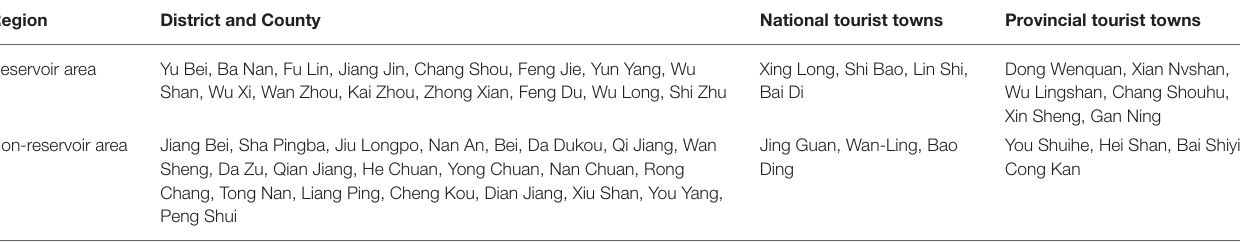
TABLE 7 | Chongqing reservoir area and non-reservoir area of three gorges project.